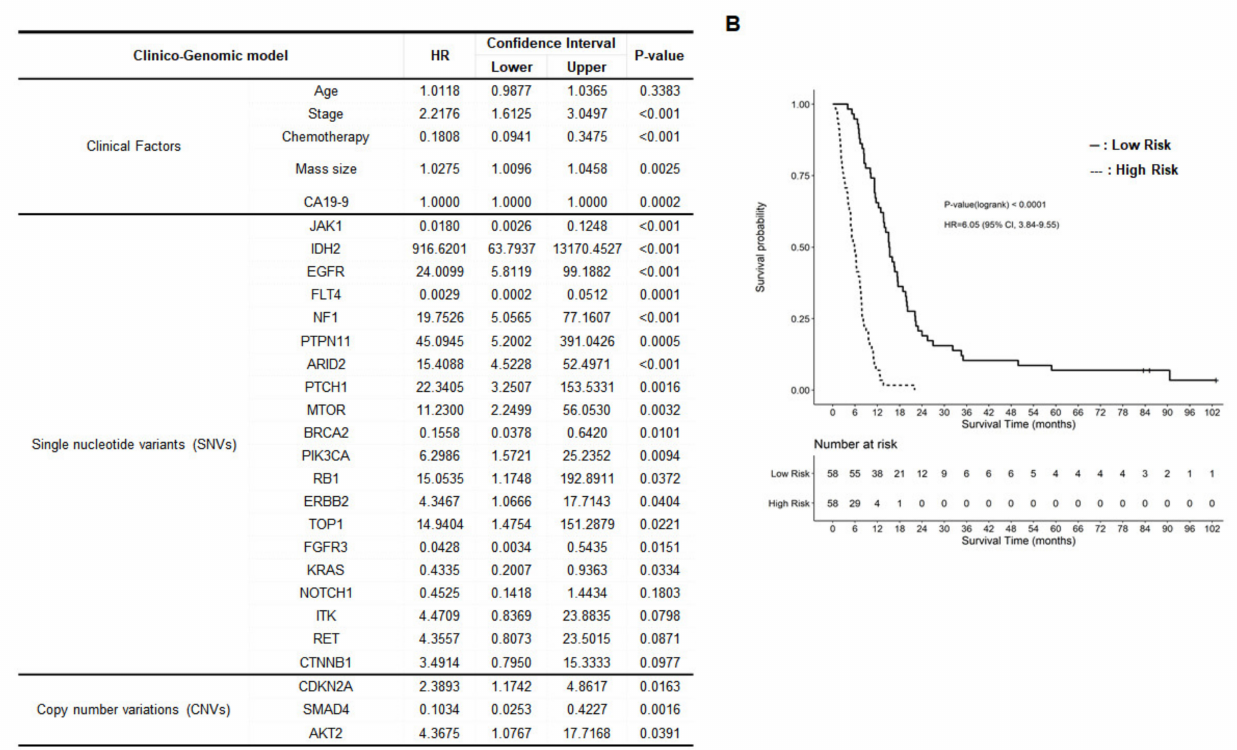
Figure 6. Clinico-genomic model. A clinico-genomic model considering clinical parameters and genomic alterations was developed to predict patient survival. ( A ) Selected factors to establish the clinico-genomic model. ( B ) Kaplan–Meier plot for the high-risk group and the low-risk group of patients with pancreatic ductal adenocarcinoma (PDAC) predicted by the clinico-genomic model ( p <